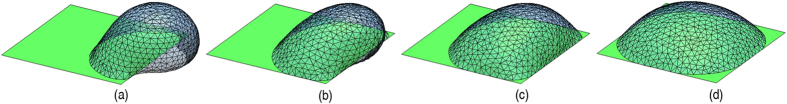
Simulation of a water droplet (1 nL) moving on a 200 μm × 200 μm hydrophilic/superhydrophobic (50°/170°) patterned surface: (a) a water droplet is placed on a patterned surface, where half of the droplet rests on the hydrophilic receptor site and other half is on the less wettable substrate; (b,c) the droplet moves towards more hydrophilic area; (d) the droplet reaches its equilibrium state.